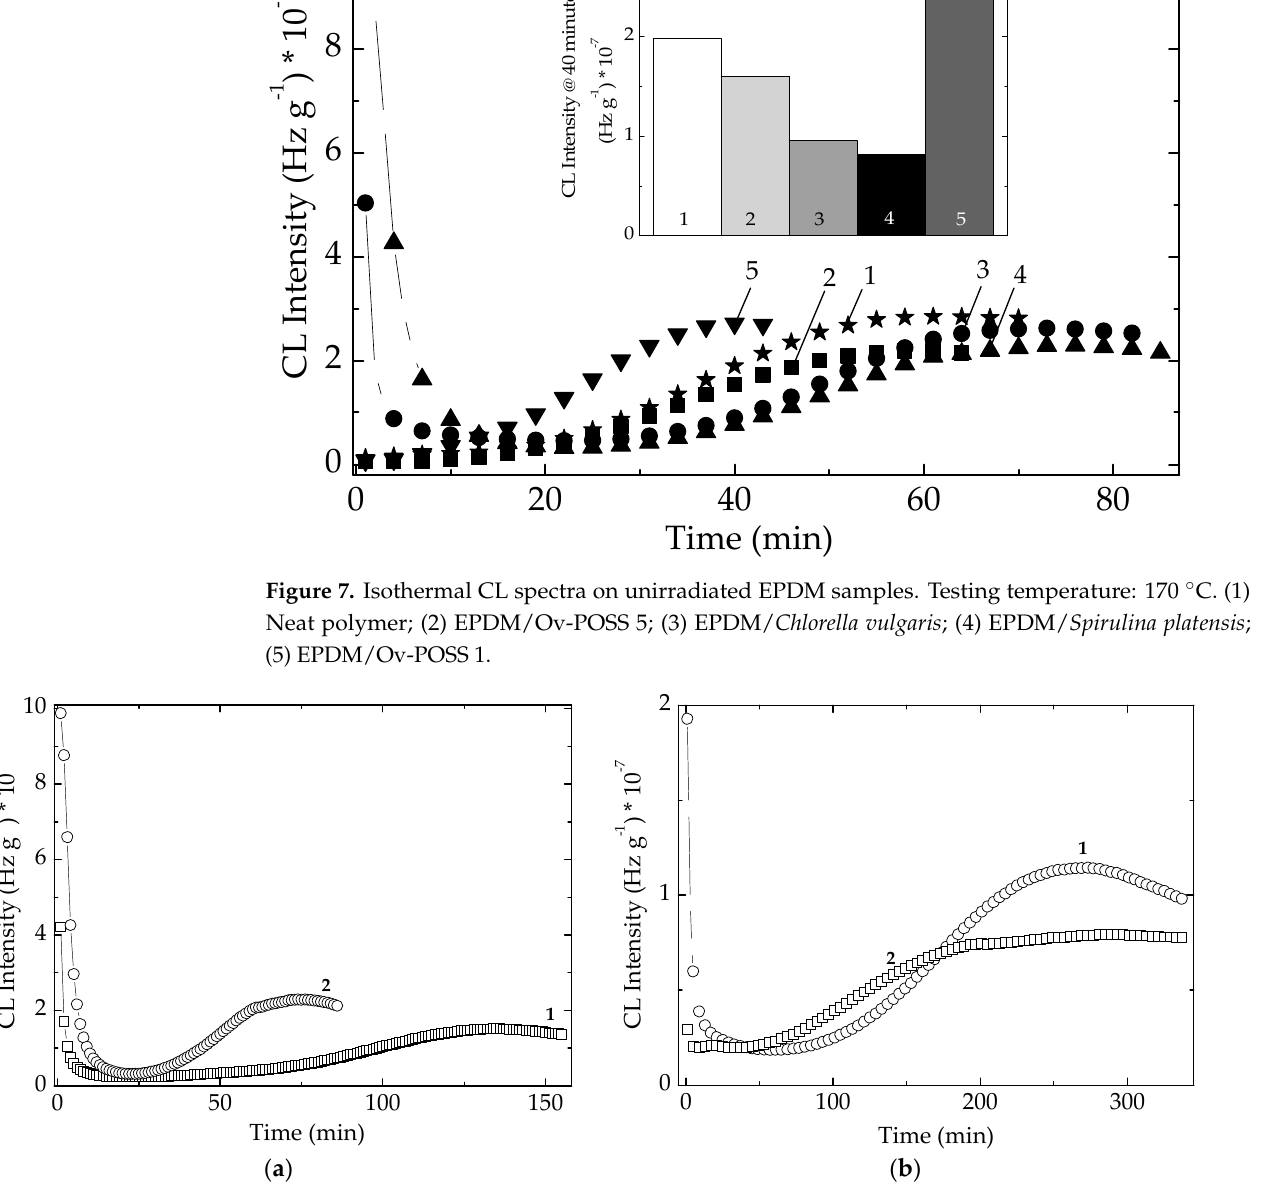
Figure 9. Isothermal spectra recorded at 150 °C on nonirradiated EPDM hybrids. (1) Neat polymer; (2) EPDM/Ov-POSS 1; (3) EPDM/Ov-POSS 5; (4) EPDM/ Chlorella vulgaris ; (5) EPDM/ Spirulina platensis ; (6) EPDM/Ov-POSS 5/ Chlorella vulgaris ; (7) EPDM/Ov-POSS 5/ Spirulina platensis . The oxidation strength of EPDM is intrinsically dependent on the structure and content of diene incorporated in the macromolecules. Consequently, the resistance against oxidation is characterized by various values of activation energies, whose values are increased when the polymer is protected by the oxidation inhibitors. Several spread values of activation energies for the oxidative degradation of EPDM have been reported, for example, 75 kJ mol − 1 [45] and 162–226 kJ mol − 1 [46]. Our figures are placed on the middle of this range, which is explained by the convenient content (5%) of diene and the medium content of propylene component (C2/C3 = 2/1). The mechanistic conformity of this performance is sustained by the influence of molecular structure, which defines the vulnerable spots, unsaturation from diene, and substituted carbon atoms from propylene moieties.